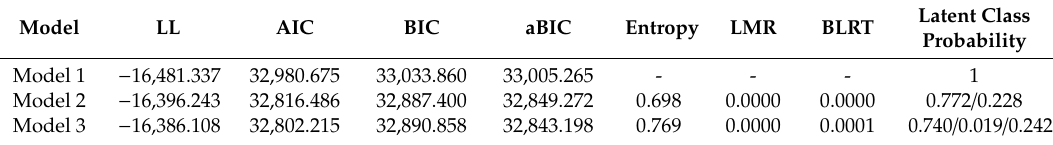
Table 6. GMM fit indexes.